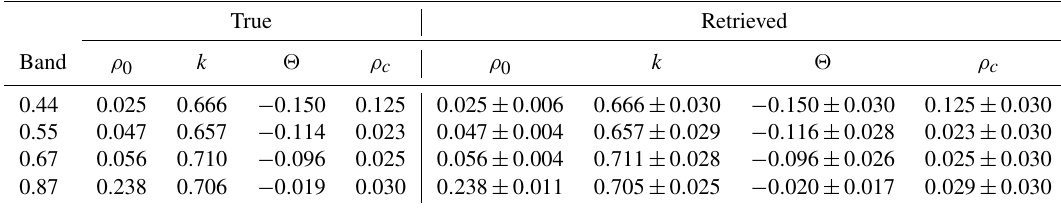
Table 5. Values of the true and retrieved surface RPV parameters for experiment F00. Wavelengths are given inµm. True Retrieved